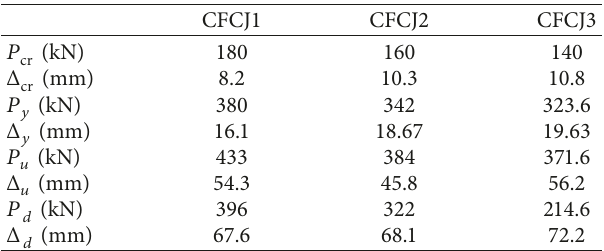
Figure 6: Failure modes observed for specimens CFCJ1 ∼ 3: (a) local buckling in lower flanges; (b) surface crack distribution in RC slabs; (c) shape of penetrating cracks in RC slabs. Table 3: Comparison of load at various